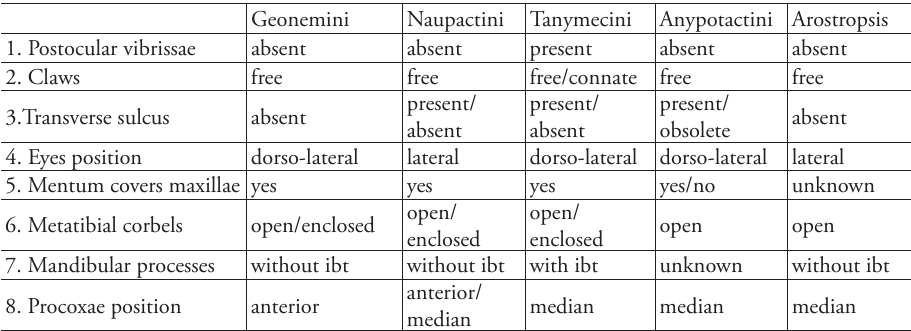
table 1. Basic morphological characters of ‘brachyderoid’ tribes of Entiminae with free claws in compari- son with the genus Arostropsis